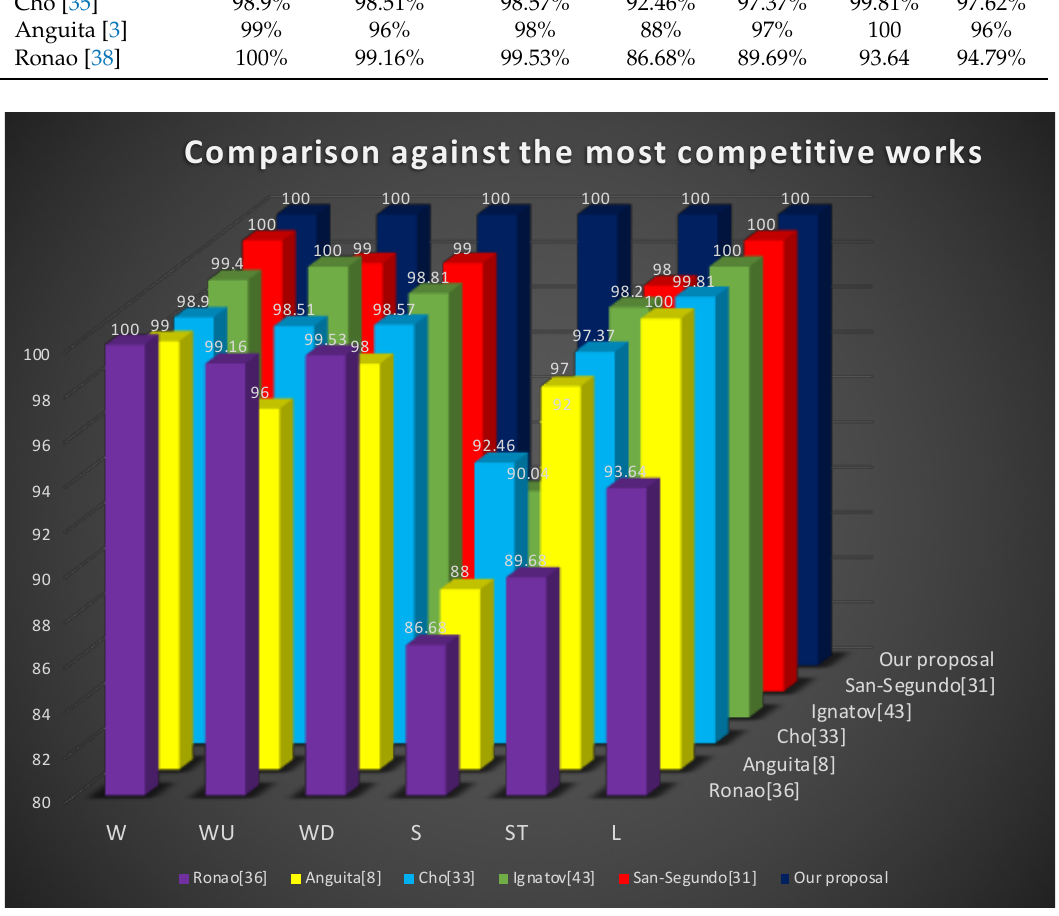
Figure 8. Performance comparison against the most competitive methods: W->walking, WU->walking-upstairs, WD->walking-downstairs, S->sitting, ST->standing and